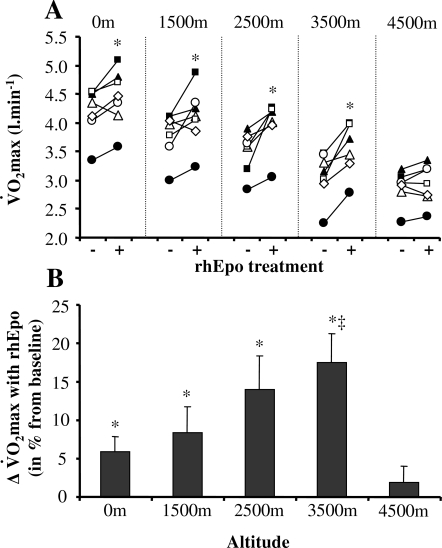
The effect of rhEpo on V̇O2max depends on the O2 inspiration fraction.This figure refers to the non-invasive study. Panel A shows the individual V̇O2max values measured before (−) and after (+) a 5-week treatment with recombinant human erythropoieitin (rhEpo), during normoxia and acute hypoxia equivalent to altitudes ranging between 1500 m and 4500 m. Panel B indicates the changes in V̇O2max induced by rhEpo, for each altitude condition. Values are means±SE in seven subjects. *P<0.05 after vs before rhEpo. ‡P<0.05 hypoxia (3500 m) vs normoxia (0 m).